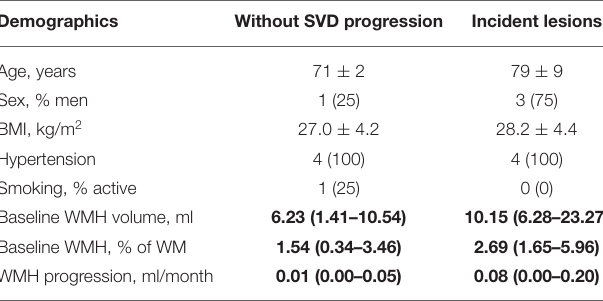
TABLE 3 | Participant characteristics of monocyte transcriptome